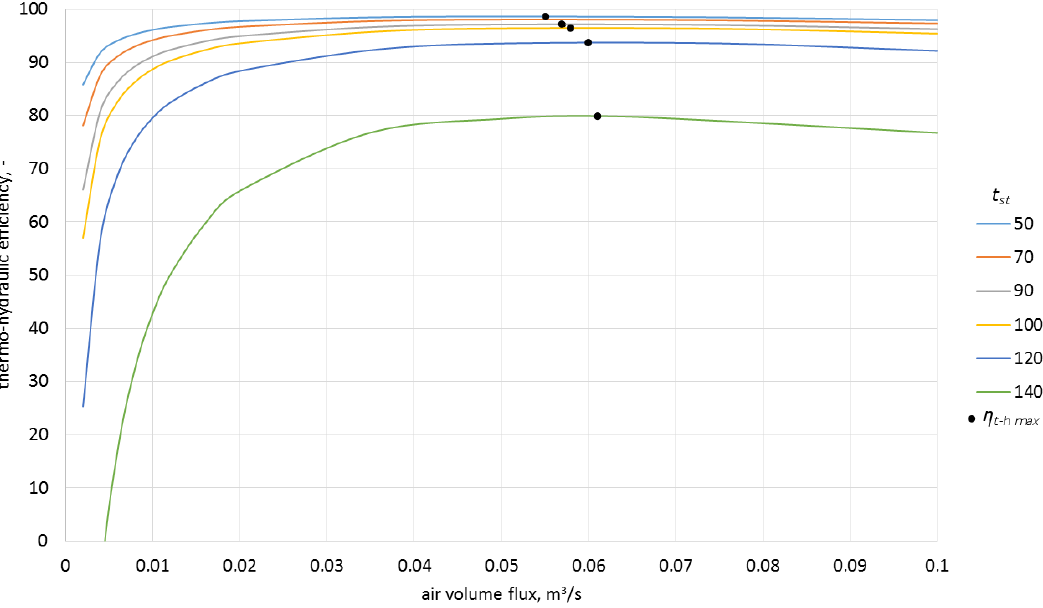
Materials 2017 , 10 , 940 Figure 12. Thermo-hydraulic efficiency for the inlet temperature of 150 ◦ C and various ceramic brick temperatures. Figure 12. Thermo-hydraulic efficiency for the inlet temperature of 150 °C and various ceramic brick temperatures.